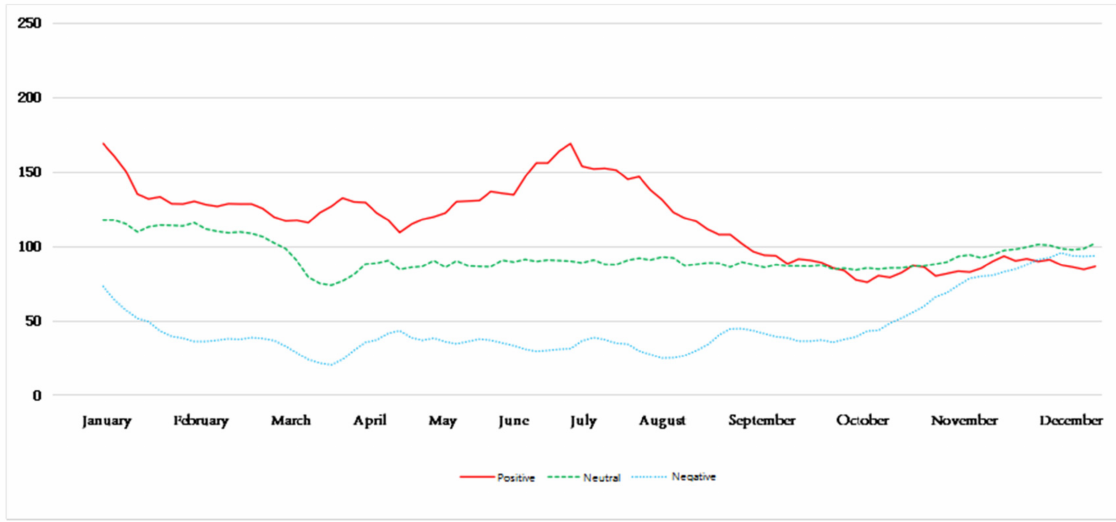
Figure 8. Five-day moving average of perceived emotions in